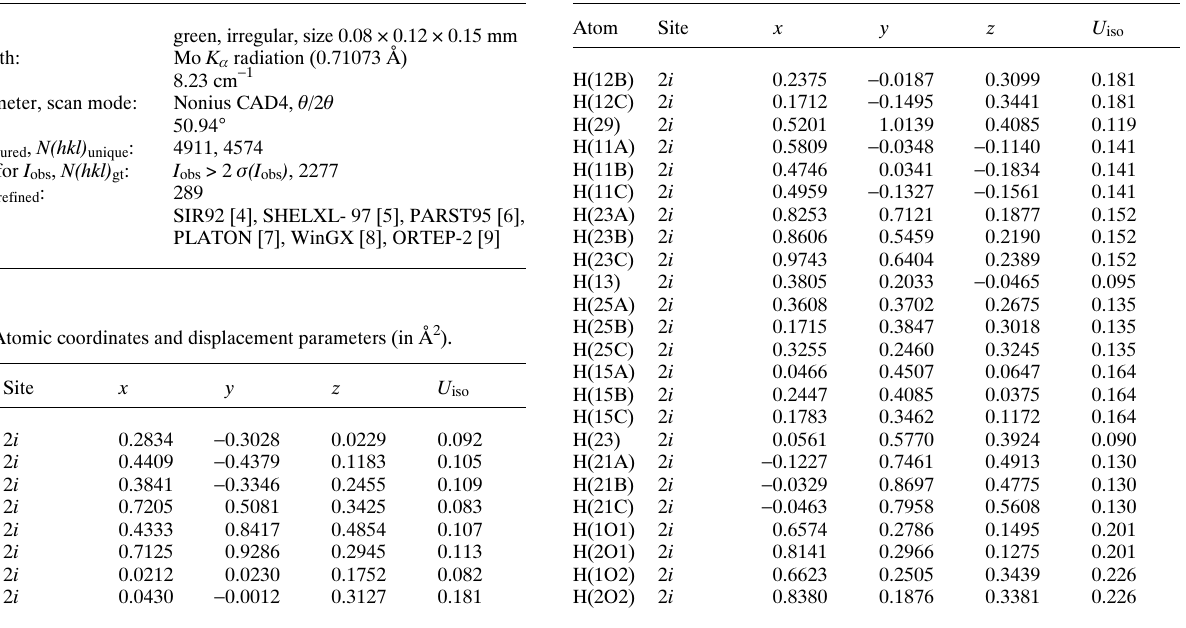
Table 1. Data collection and